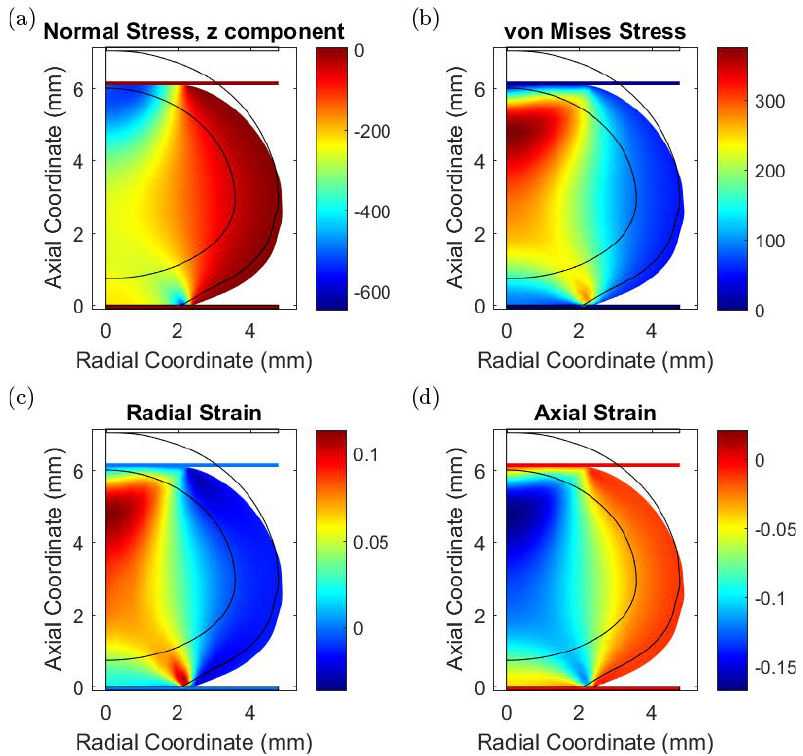
Fig. 7. Spatial variation of (a, b) stress and (c – f) strain within the Model A (homogeneous) decapsulated porcine lens at 15% com- pression. Note that the stress and strain are very heterogeneous throughout the lens. In general, the maximum value of the axial strain within the lens was similar to the applied fractional compression. However, stresses and strains varied signi¯cantly through the lens.